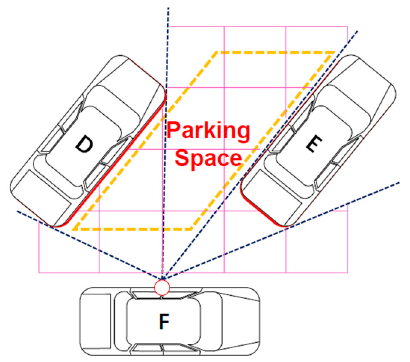
Figure 15. Oblique parking mode.